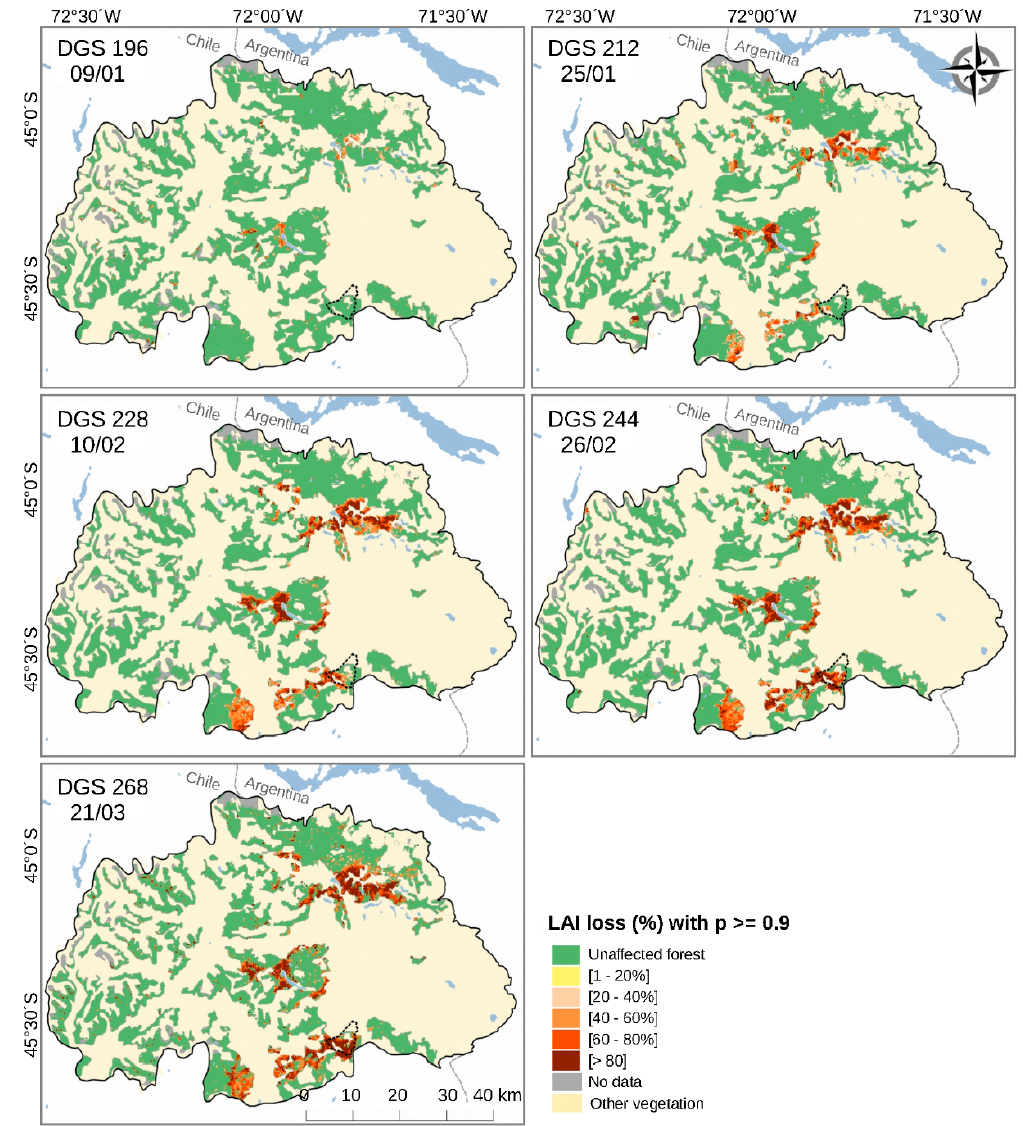
Figure 7. Spread of the insect outbreak during the 2015–16 growing season in terms of LAI loss